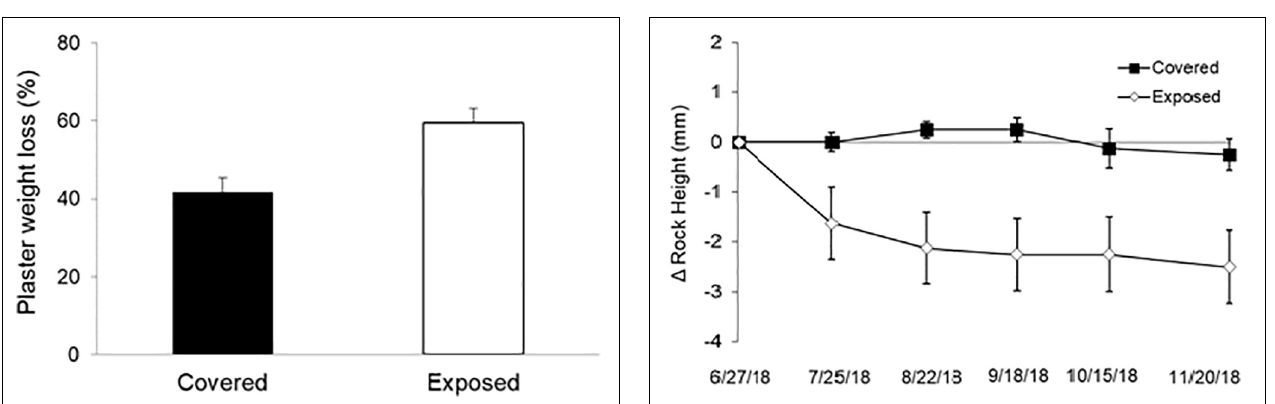
FIGURE 6 | Variations in the height of mussel-covered and mussel-removal (exposed) benches during the study period. The experiment began on June 27, 2018, and the differences among treatments were significant on all subsequent sampling dates ( p < 0.05). The vertical lines above and below the data points indicate 1